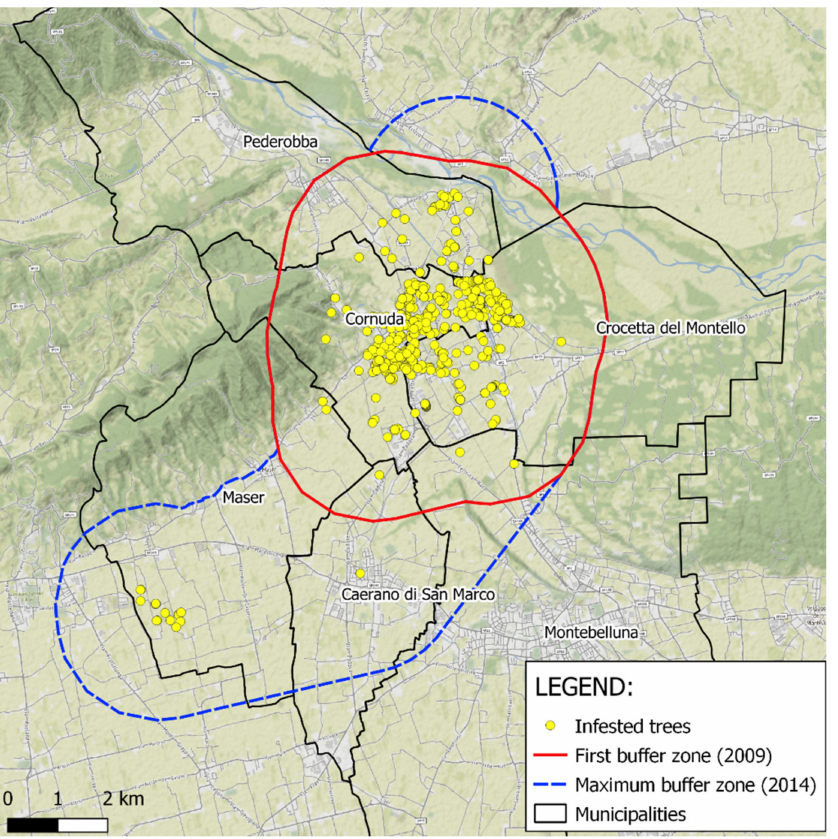
Figure 2. Map of the A. glabripennis infestation, with position of infested trees, involved municipalities border and first and maximum buffer zones